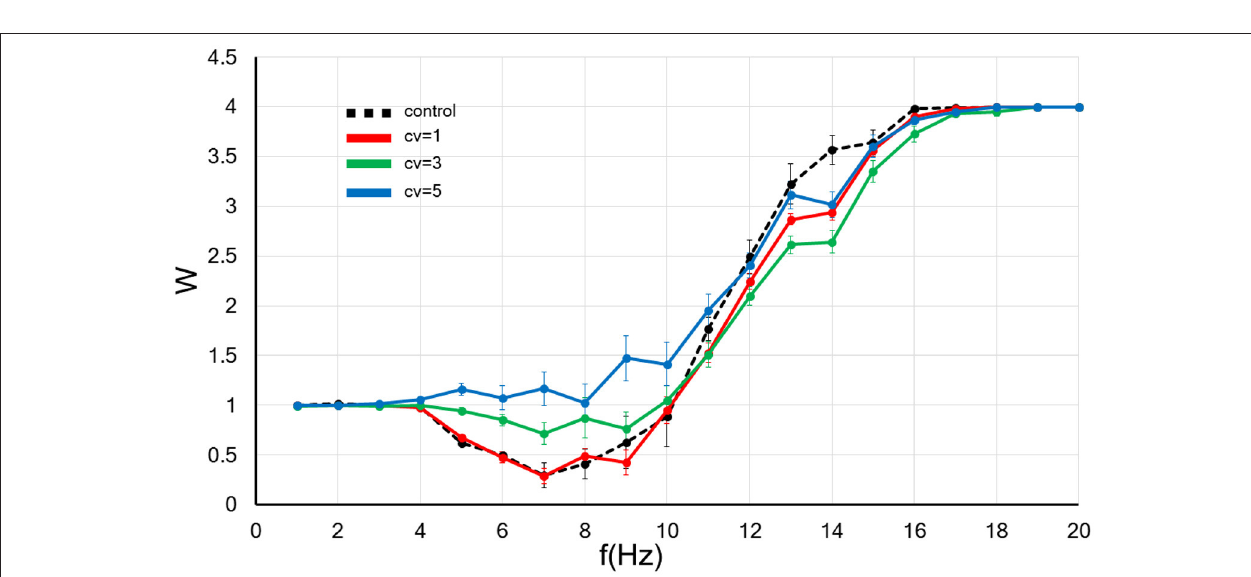
FIGURE 3 | The CV of the amplitude for the background synaptic activity regulates the frequency-dependence of the synaptic strength. The x -axis shows the input frequency, and the y -axis indicates the relative synaptic weight. W < 1, W > 1, and W = 1 indicates the synaptic strength weakens, becomes more robust and do not change, respectively. A black dotted line indicates the control without applied the fluctuation. In contrast, the results of background synaptic activity with fluctuations in the CV = 1, 3, and 5 are shown by red, blue and green lines. Error bars indicate the standard error of the mean (SEM).